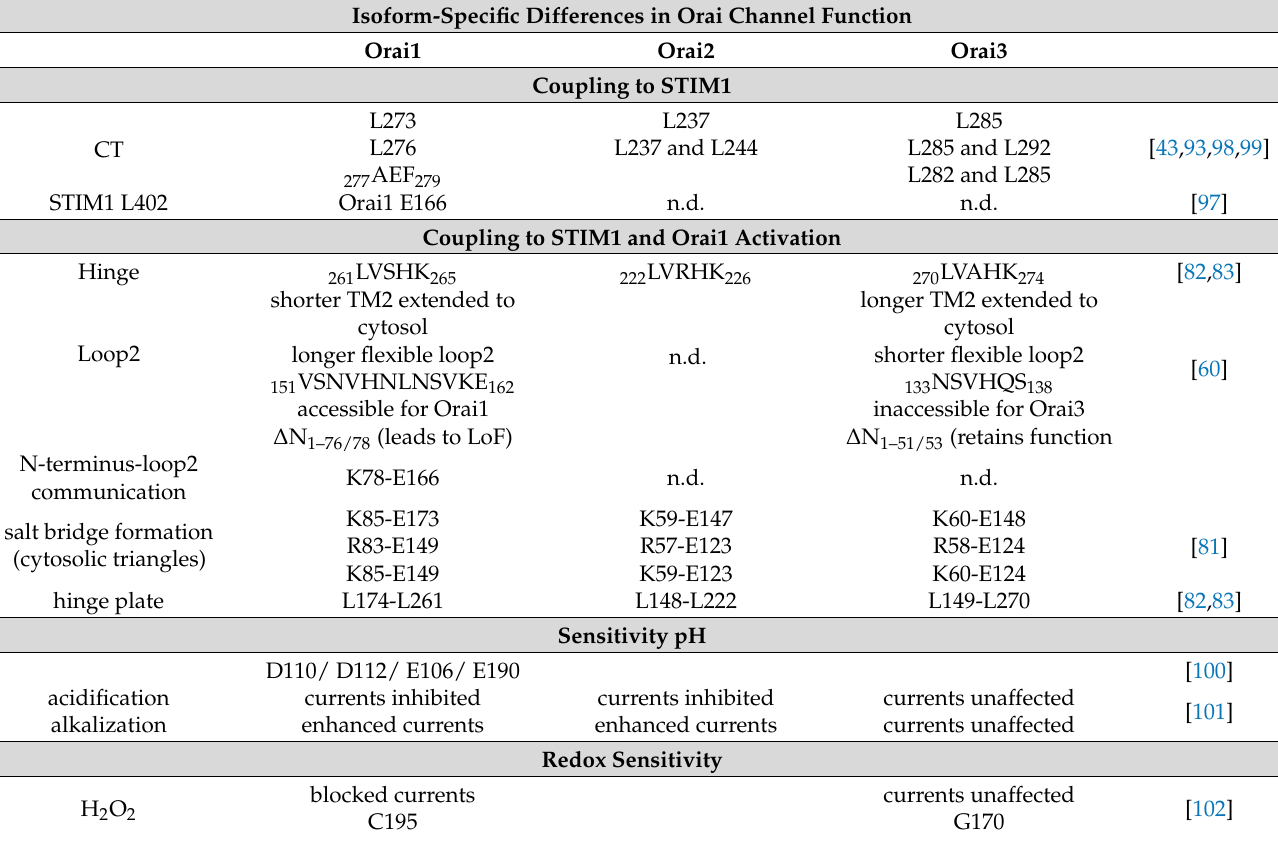
Table 3. Isoform-specific differences in regions determining STIM1-Orai1 coupling, Orai1 activation, pH sensitivity and redox